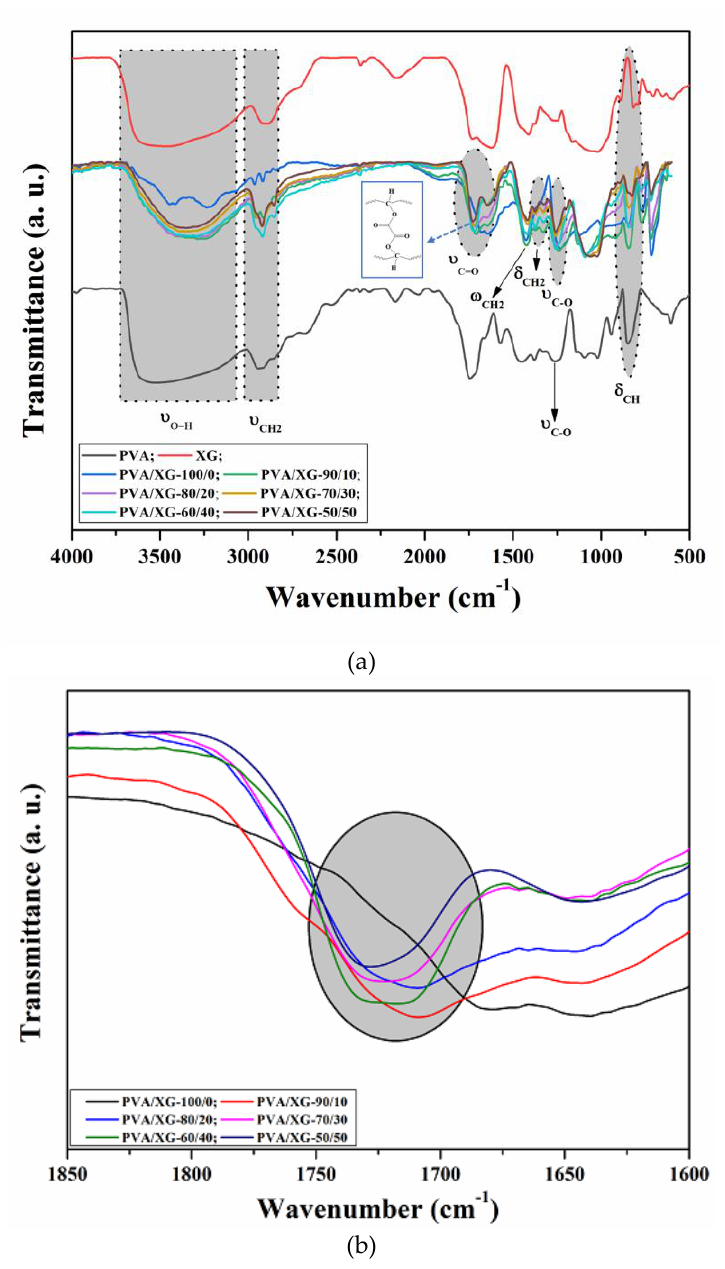
Figure 3. ( a ): FTIR spectra of the PVA, XG, and PVA/XG hydrogels; ( b ): Enlarged FTIR spectra in the region of 1730 cm −1 for the PVA, XG, and PVA/XG hydrogels.